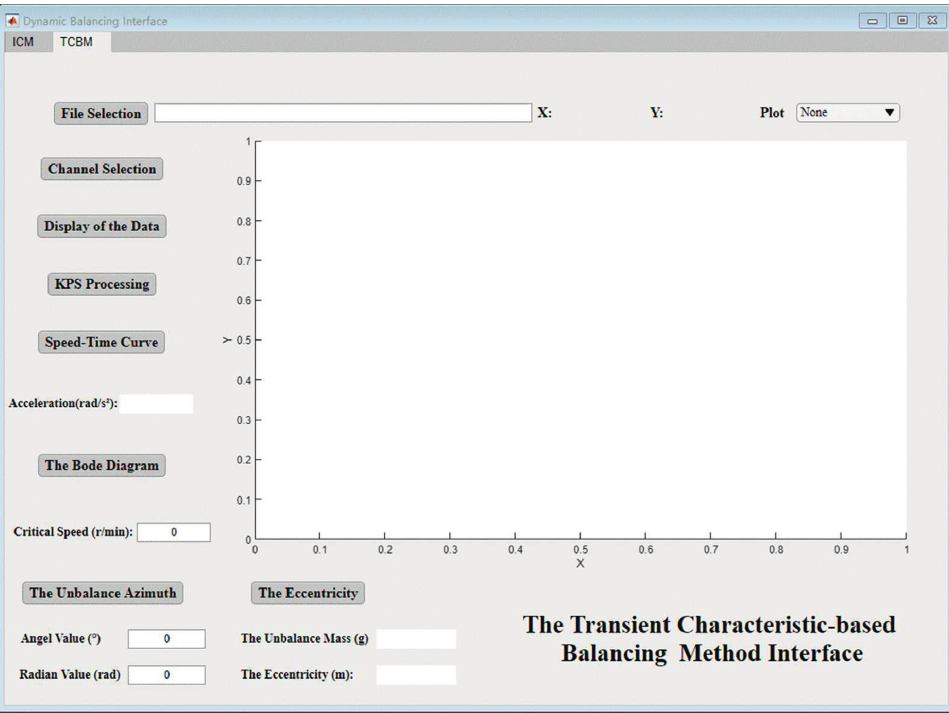
Figure 10: The transient characteristic-based balancing method